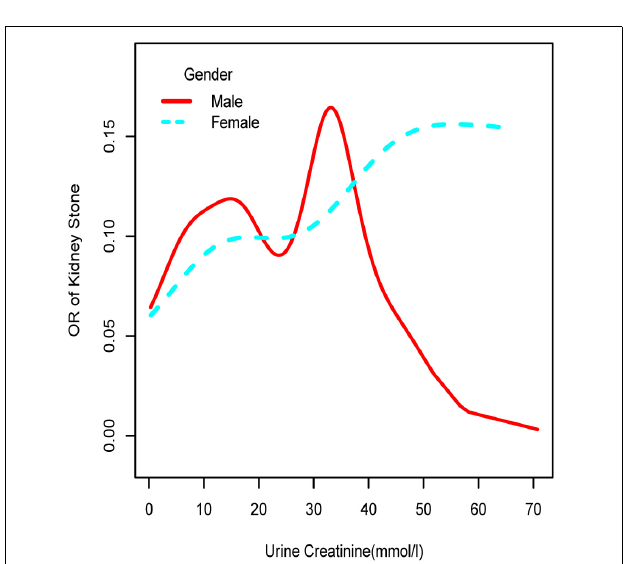
FIGURE 4 | Smooth curve fittings model explained the correlation between serum creatinine and UCR. The central part of the two blue curves represents